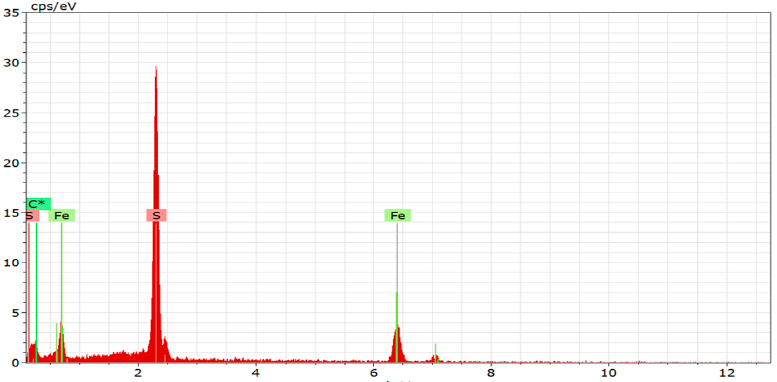
Figure 5. Framboidal pyrite (above) with EDS analysis (below). Microcrystallites are close to the limit of SEM resolution. The star indicates a peak of the C which is coming from the carbon coating of the sample. Sample RIC 3.